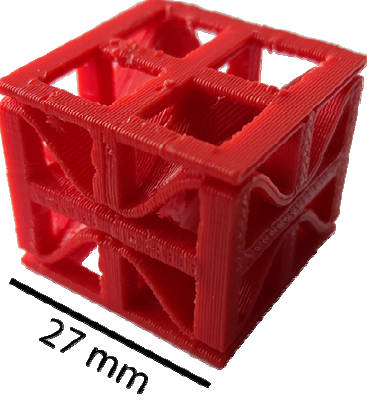
Figure 28. 3D 3D printed structure's sample with T1 = 1 mm; T2 = 3 mm and L = 12 mm